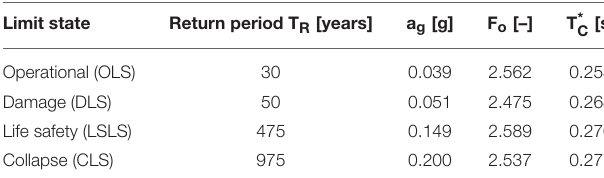
TABLE 1 | Seismic parameters of elastic spectra according to the NTC 2008 standard.